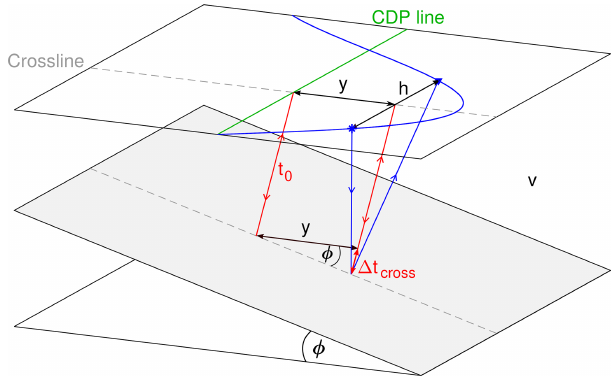
Figure 3. Ray geometry for a crooked acquisition line above a cross-dipping reflector. y denotes the cross-offset, h the offset be- tween shot and receiver, φ the cross-dip angle, v the medium veloc- ity and t 0 the zero-offset travel time for a ray without